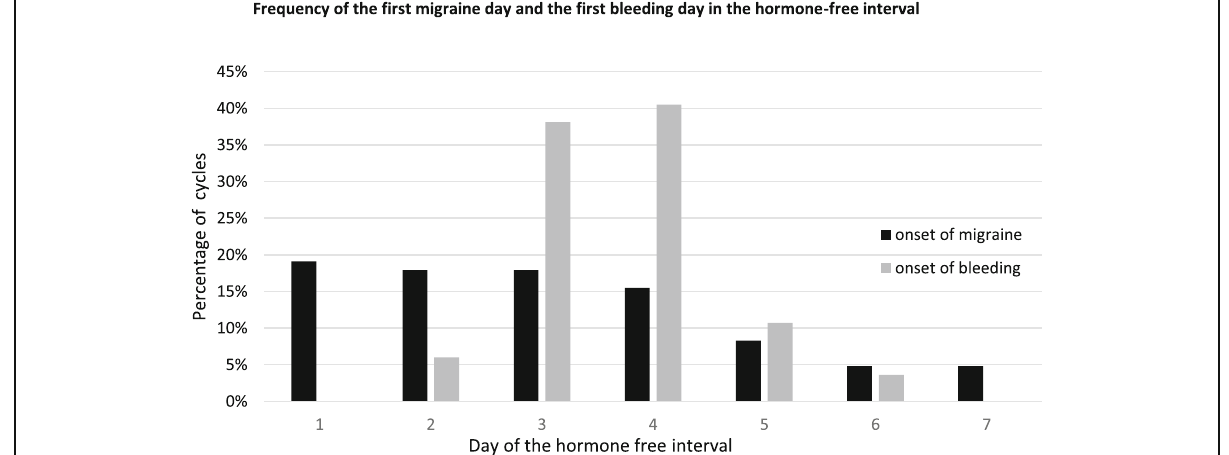
Fig. 3 Frequency of the first migraine day and the first bleeding day in the hormone-free